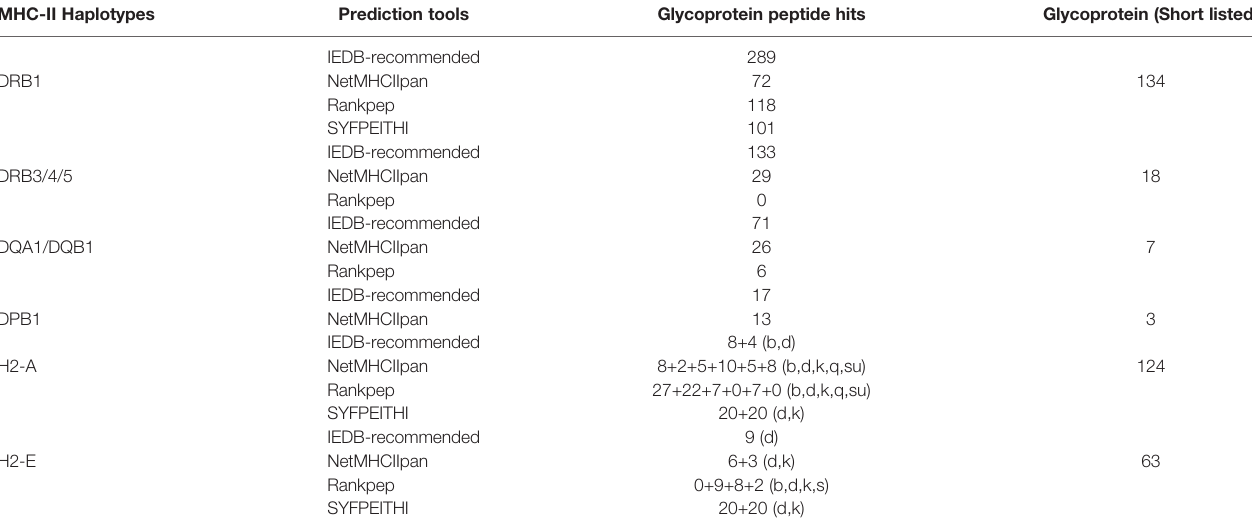
TABLE 1 | HTNV glycoprotein MHC-II epitope